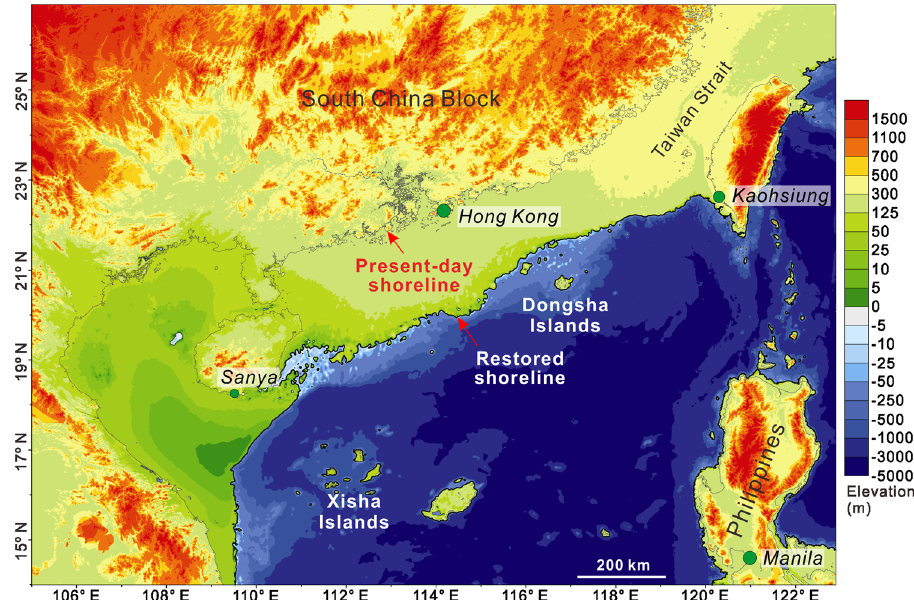
Fig. 4 Restoration of paleoshorelines and paleobathymetry at 0.54 Ma. The restoration shown considers both the relative sea-level change and sediment supply. The restored paleoshorelines are located several hundred kilometers oceanward, close to the present-day shelf break. See Supplementary Fig. S1 for the restoration of paleoshorelines at 0.54 Ma only considering the effect of relative sea-level changes and sediment supply.